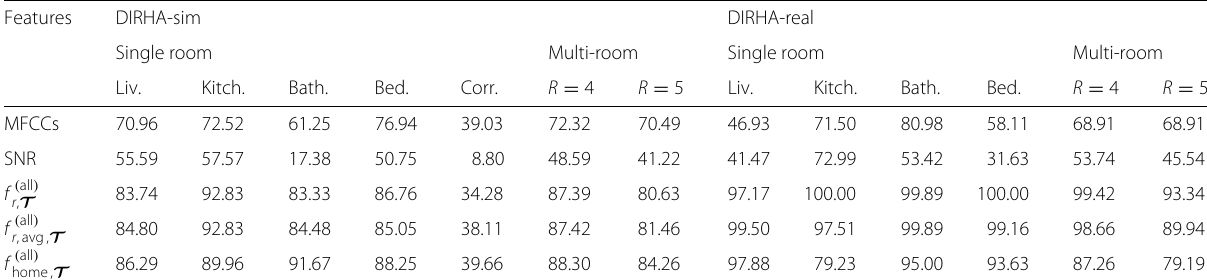
Table 5 Comparison of the two baselines of Section 6 (upper part) and the room discriminant feature-based approach (lower part) for the room-inside vs. room-outside speech classification task Features